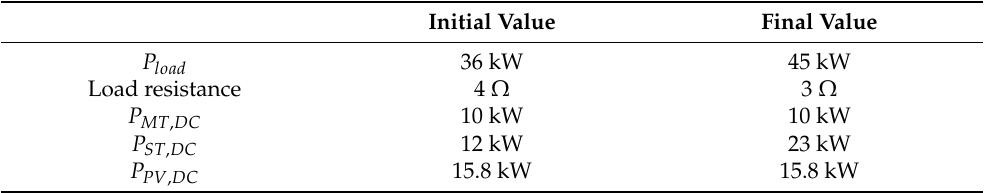
Table 9. Power production variation to achieve the objective. Values shown considered rated voltage.